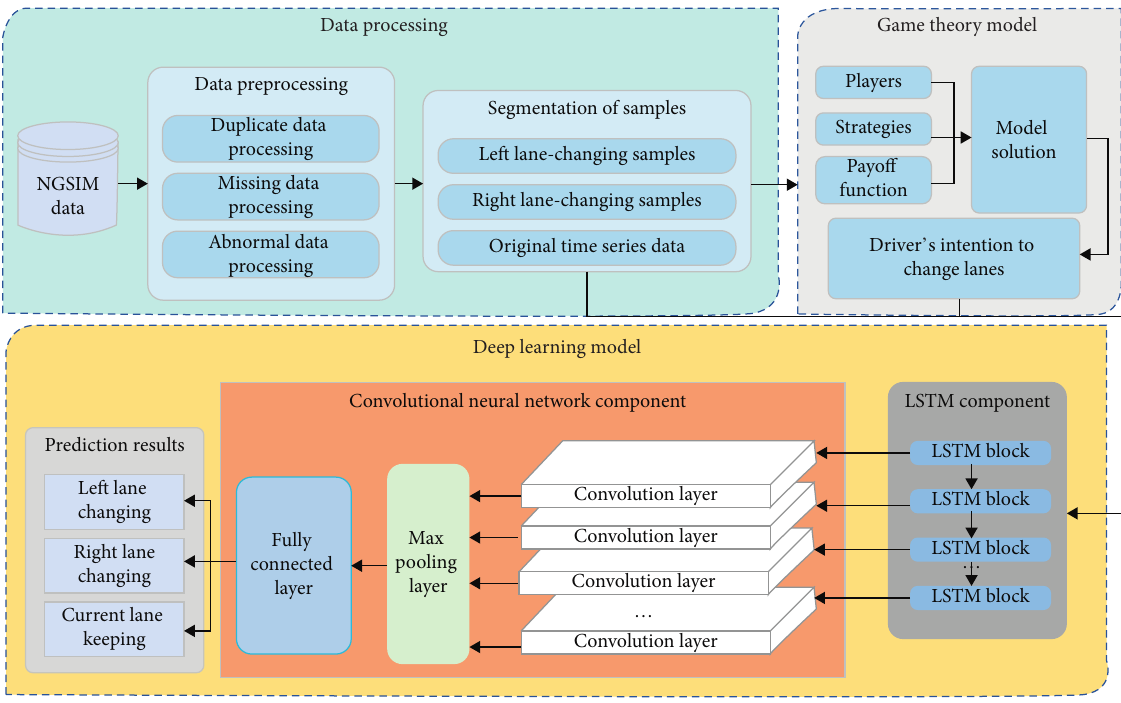
Figure 2: Model architecture and data flow.